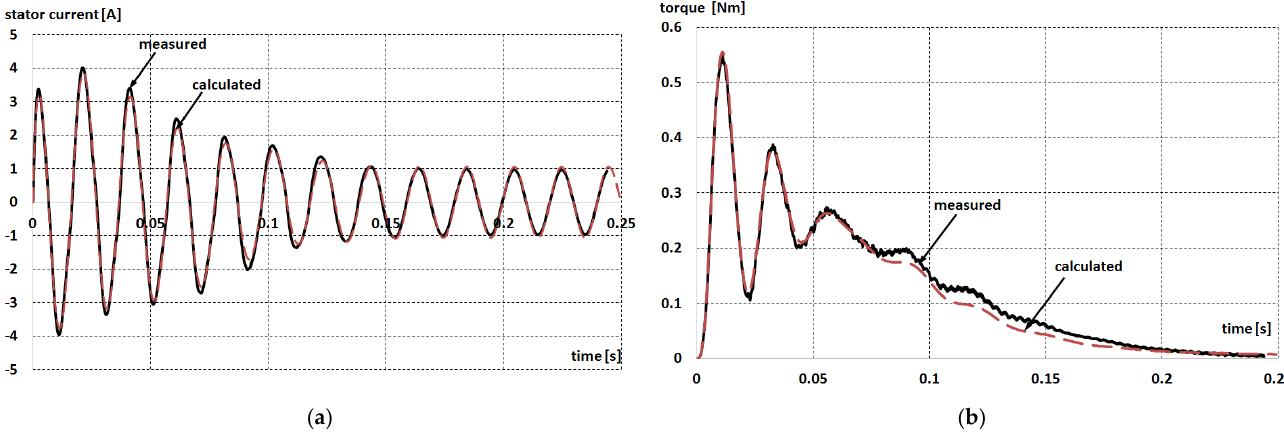
Figure 5. Measured and calculated time waveforms of the instantaneous value of the current in the stator phase winding ( a ) and the electromagnetic torque ( b ), and the rotational speed of the motor during direct motor starting, when supplied from the mains with a voltage of 50 Hz, for the motor without additional inertial mass ( Js = 0.00009 kg m 2 ).